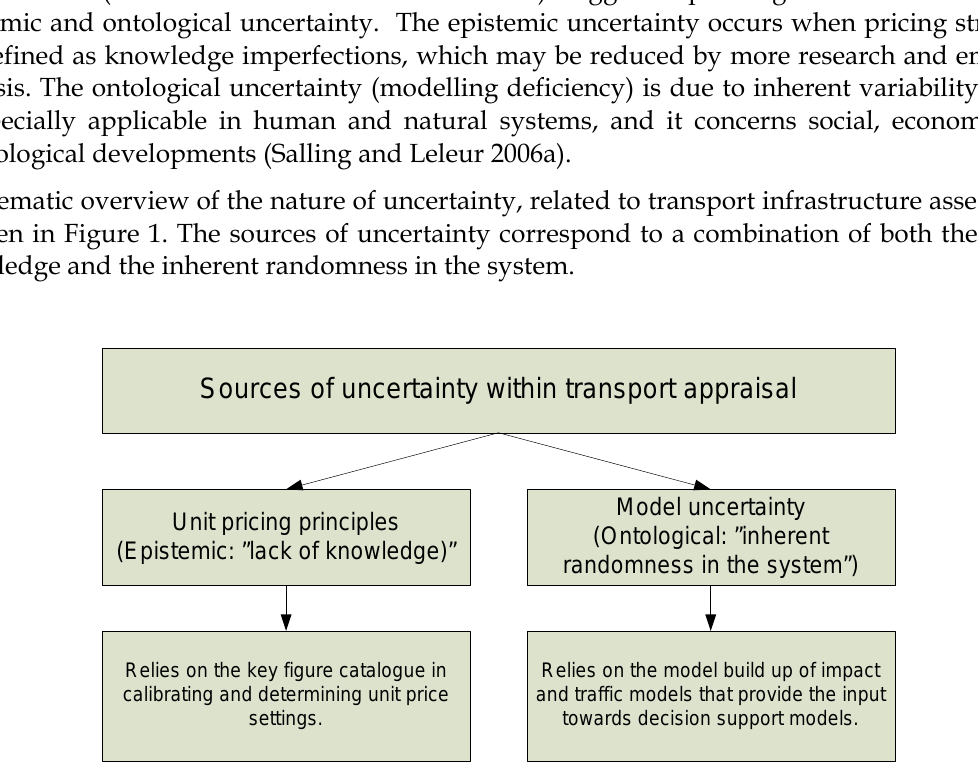
Figure 1. Schematically overview illustrating the two major sources of uncertainty embedded within transport infrastructure assessment (adapted from Salling and Leleur